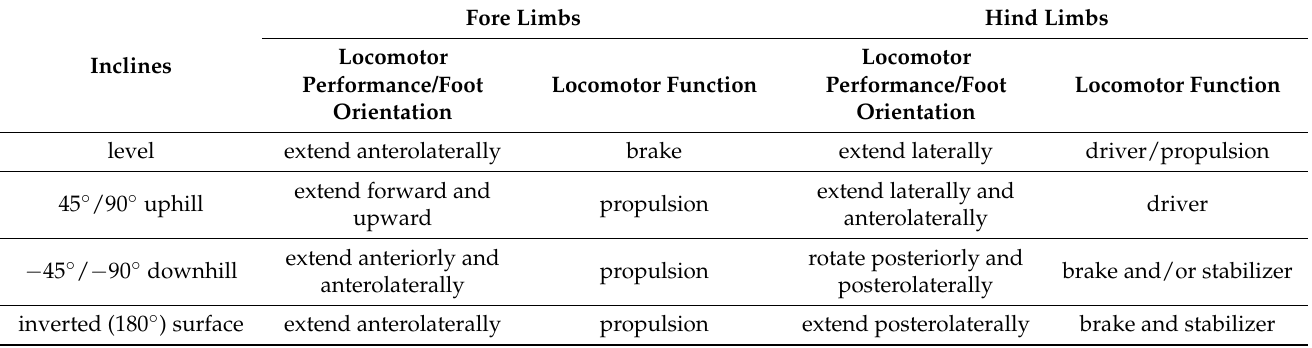
Table 1. Comparison of locomotor performance and function in gekkonid limbs at different